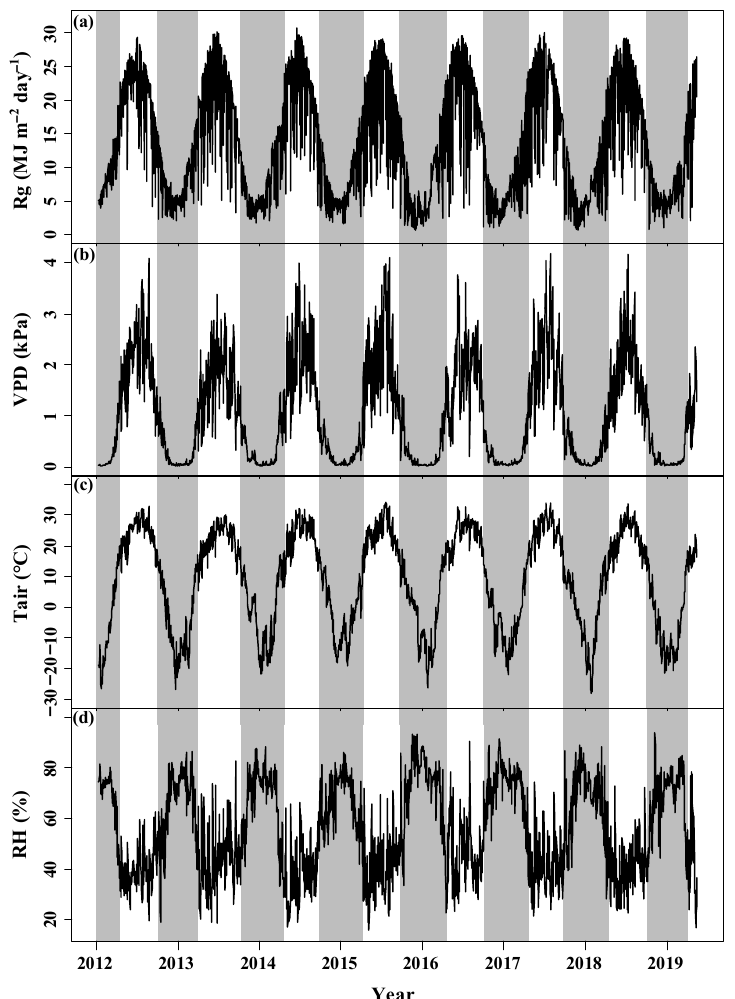
Figure 2. Meteorological conditions during the study period: ( a ) global radiation (Rg), ( b ) vapor pressure deficit (VPD), ( c ) air temperature (Tair), and ( d ) relative humidity (RH). White and gray shading indicates the growing season and the dormant season, respectively.